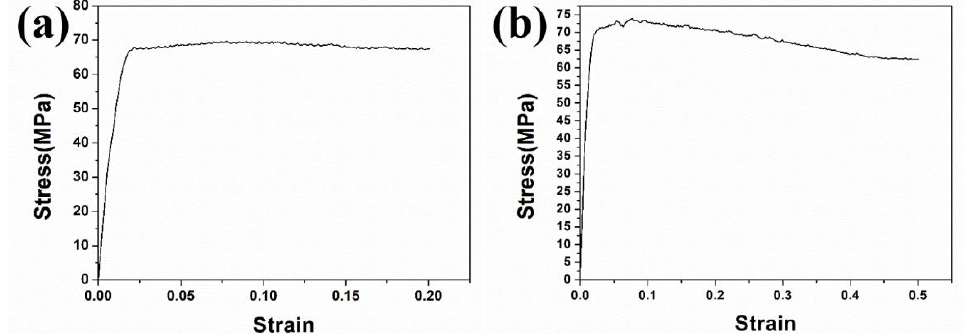
Figure 1. Typical stress-strain curve obtained at a strain rate of 0.01 s − 1 at 1150 ◦ C to a strain of ( a ) 0.2 and ( b ) 0.5, respectively.